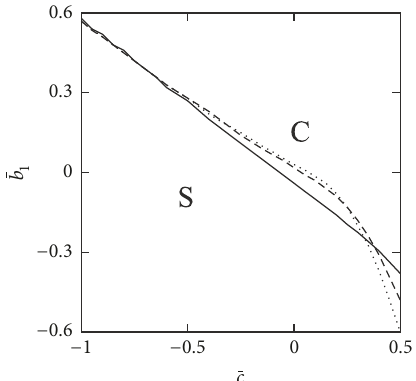
Figure 9: Phase diagram of spot motion in the 𝑐 - 𝑏 1 plane. Data are obtained by the simulation of the full tensor model. 𝑏 𝑠 = 0.1 . The marks S and C in the figure represent regions of straight motion and circular motion, respectively. The solid, dashed, and dotted curves correspond to the cases of (𝛾,𝜅) = (0.25, 0.3) , (0.5, 0.5) , and (1.0, 0.8) ,